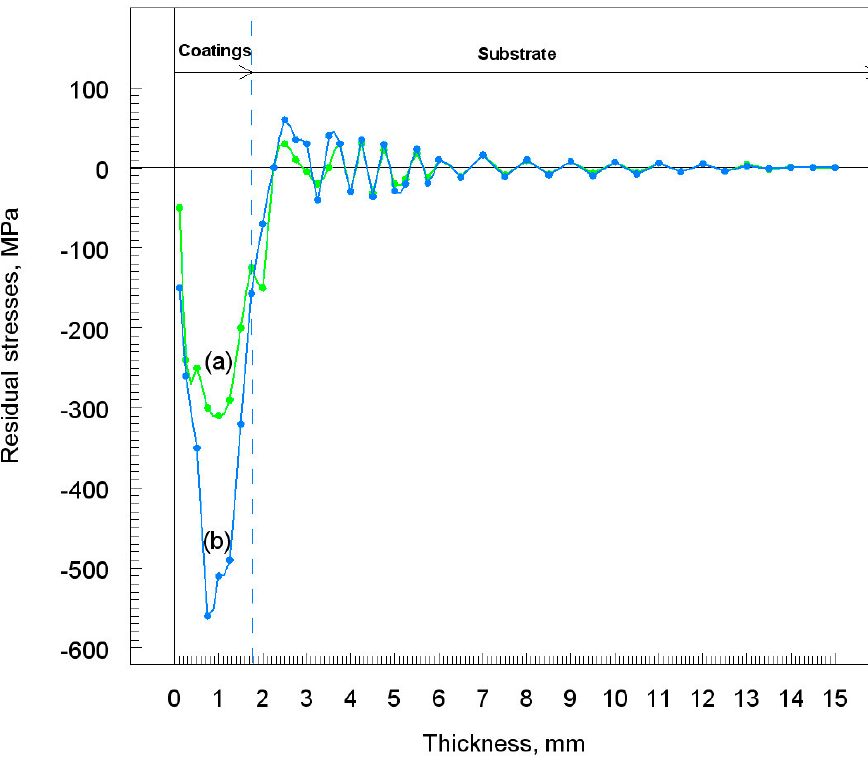
Figure 14. Residual stress profile of nickel coatings on the Al7075 substrate: ( a ) M28, and ( b ) O60